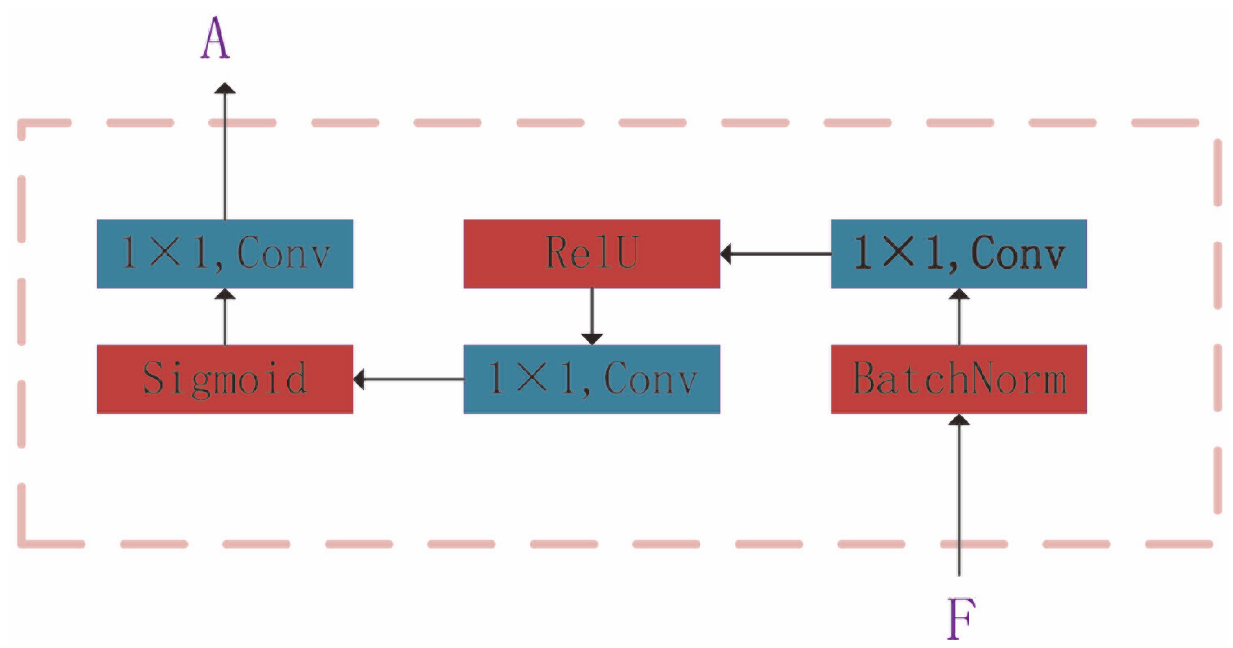
Figure 3. Detailed structure of the attention module. The attention mechanism network mainly takes the output feature map F of the efficient net as input, which is then put into three 1 × 1 convolutional layers. The activation functions ReLU and Sigmoid are added after the batchnorm operation to convert the input into nonlinear features.